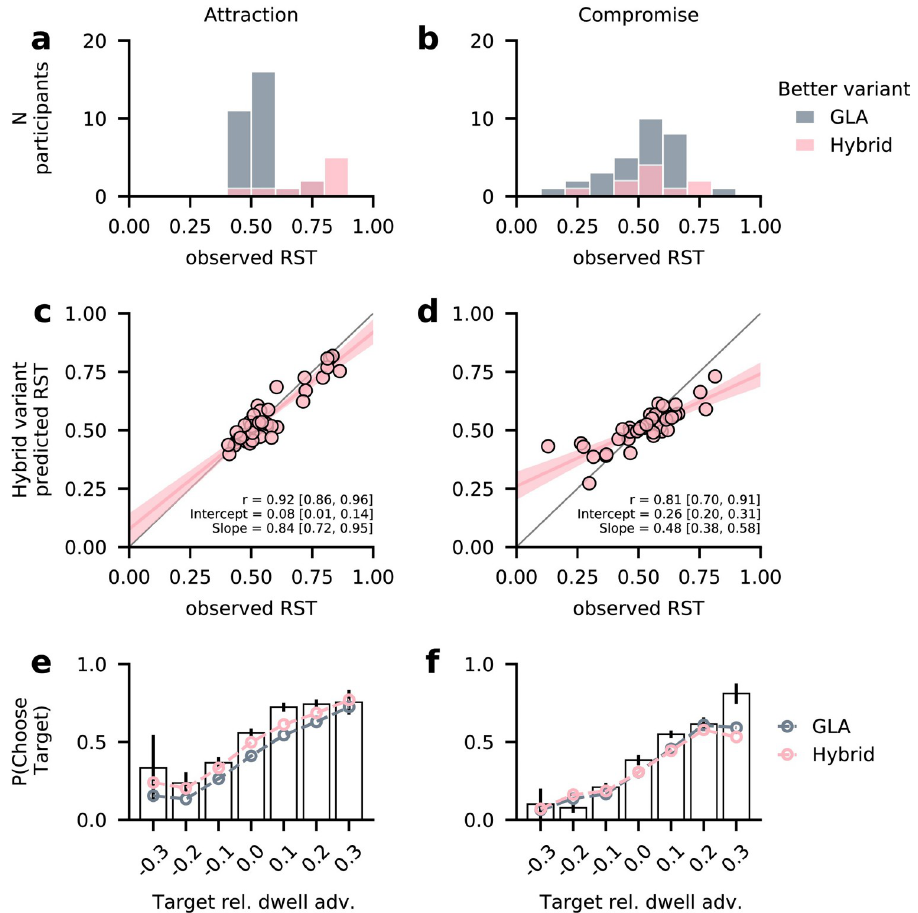
Fig 5. Hybrid model variant details. (a, b) Number of participants better described by the hybrid variant (pink) or the GLA (grey), dependent on strength of attraction (a) and compromise (b) effects. Participants with strong attraction effects were better described by the hybrid variant. (c, d) Individual observed and predicted RST in attraction (c) and compromise trials (d) . Compared to GLA (Fig 3I and 3J), the hybrid model better predicted strong attraction effects for some participants. Predictions of compromise effects are similar. (e, f) Observed and model-predicted probability of choosing the target alternative, depending on the target’s relative dwell time advantage. Like other gaze-dependent models (Fig 3), the hybrid variant generally captured the positive association between gaze and choice. In contrast to GLA, however, it predicted an overall higher probability of choosing the target in attraction trials (e) . Predictions in compromise trials (f) are similar to GLA. White bars and error bars indicate mean ± s.e. observed data from even- numbered trials. Model predictions are based on 50 simulations for each odd-numbered